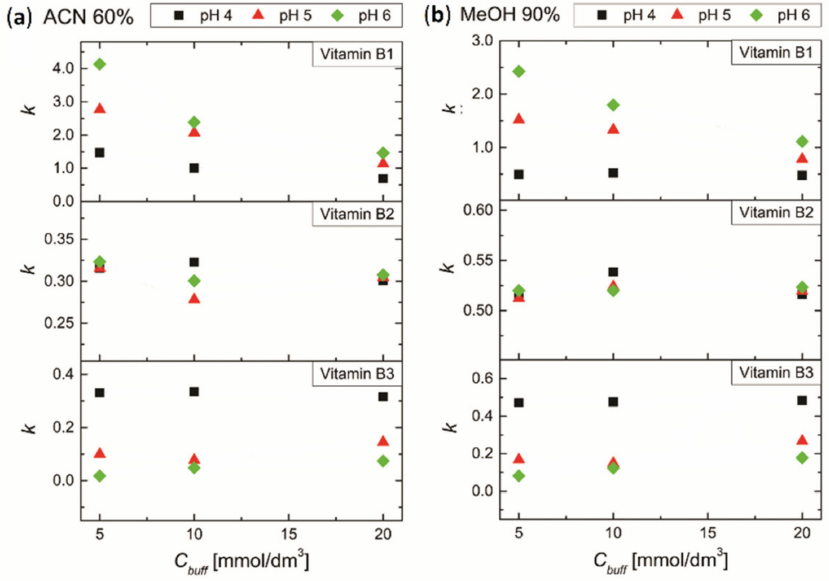
Figure 13. Effect of buffer pH and concentration on retention of vitamins in column N (Nucleodur C18 Gravity–SB) with: ( a ) 60% content of acetonitrile and ( b ) 90% content of methanol in mobile